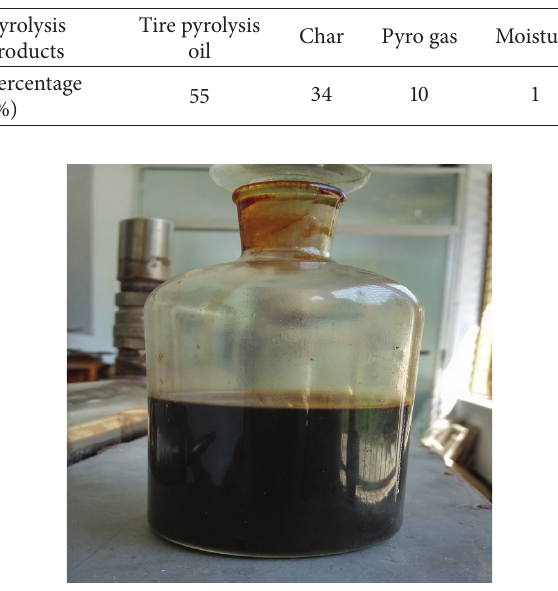
Figure 2: Crude tire pyrolysis oil from waste tire.